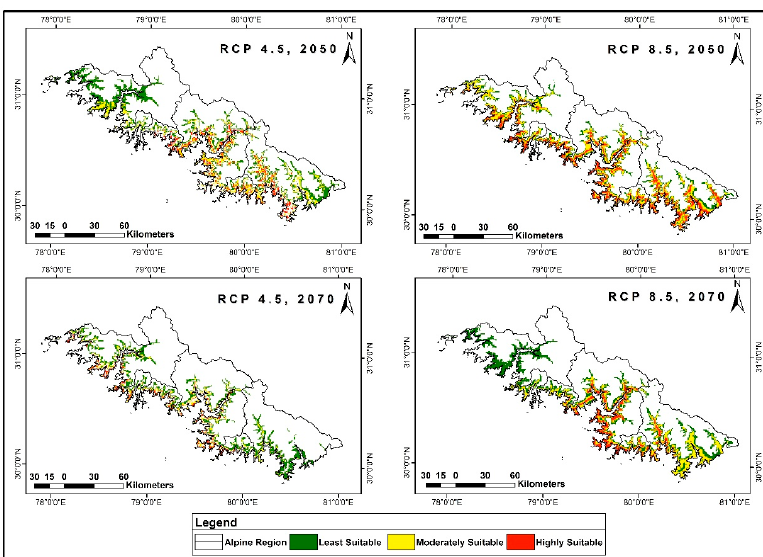
Figure 3. Predicted future habitat suitability for C. cordigerum.